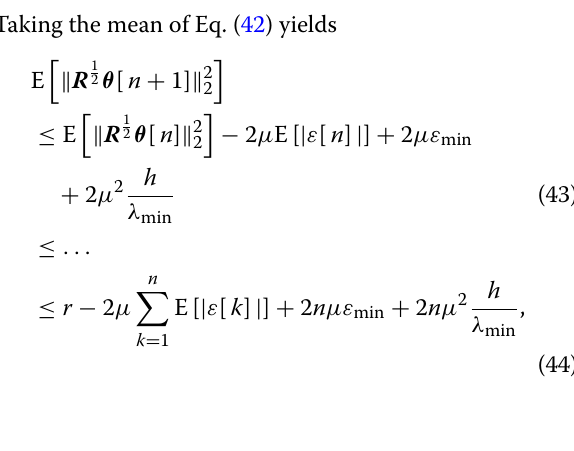
Table 3 Decoding speed (Eq. (37)) comparison